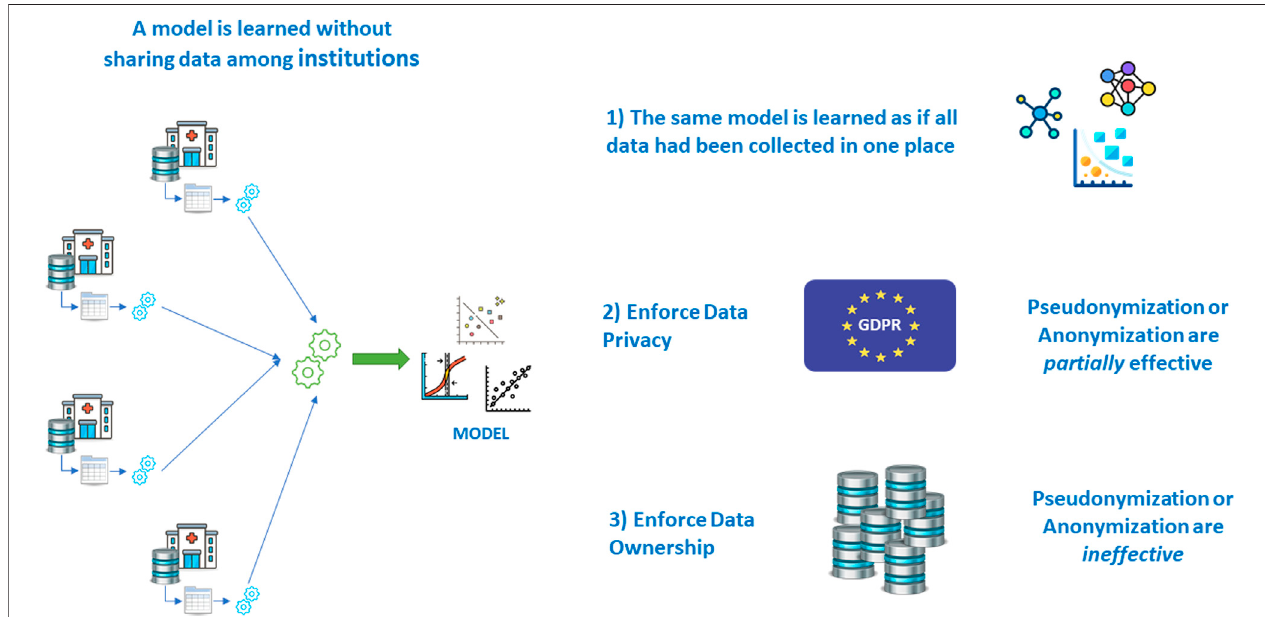
FIGURE 14 | Main characteristics of Federated Learning.